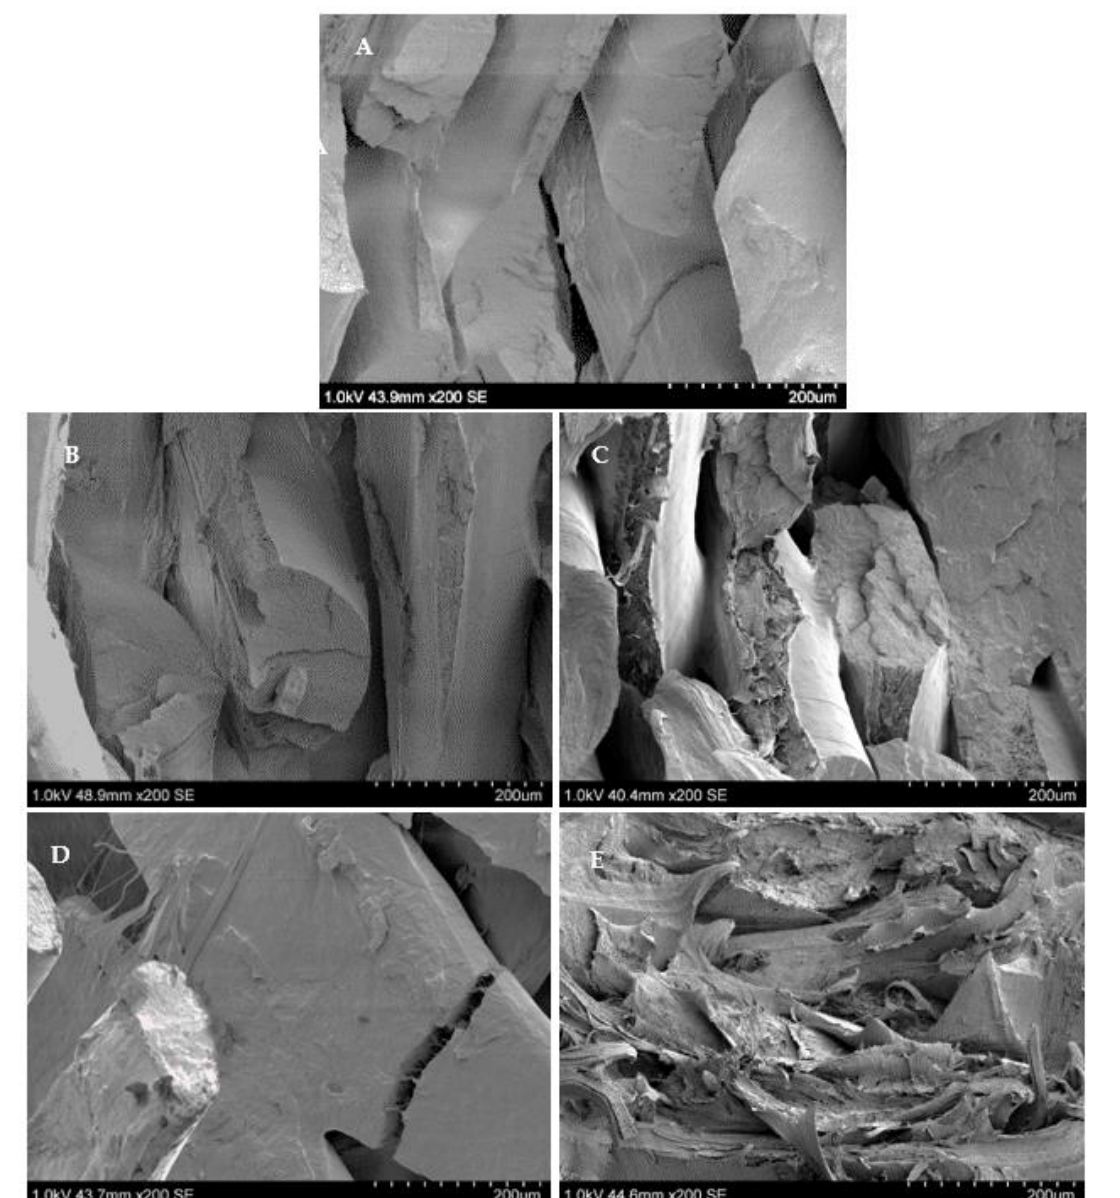
Figure 9. SEM micrographs of flexural test 3D printed test specimen fractured surfaces: ( A ) Denotes PHB (55%)/PLA (45%); ( B ) Denotes PHB (55%)/PLA (45%) + 2 wt.% CC; ( C ) Denotes PHB (55%)/PLA (45%) + 4 wt.% CC; ( D ) Denotes PHB (55%)/PLA (45%) + 6 wt.% CC; ( E ) Denotes PHB (55%)/PLA(45%) + 8 wt.% CC.